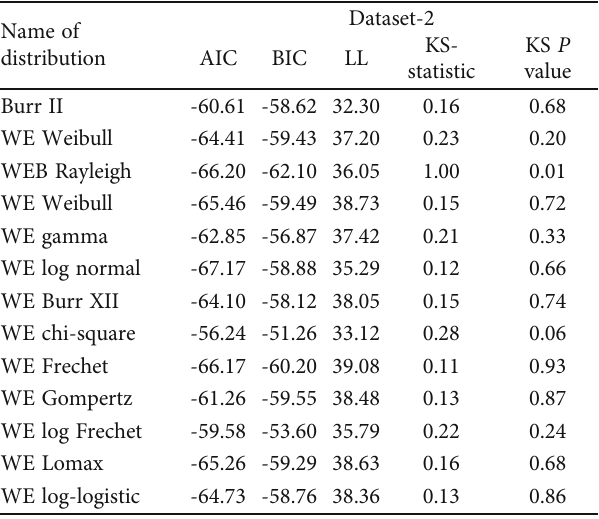
Table 21: Comparison of BT-IID with class of WEGDs using